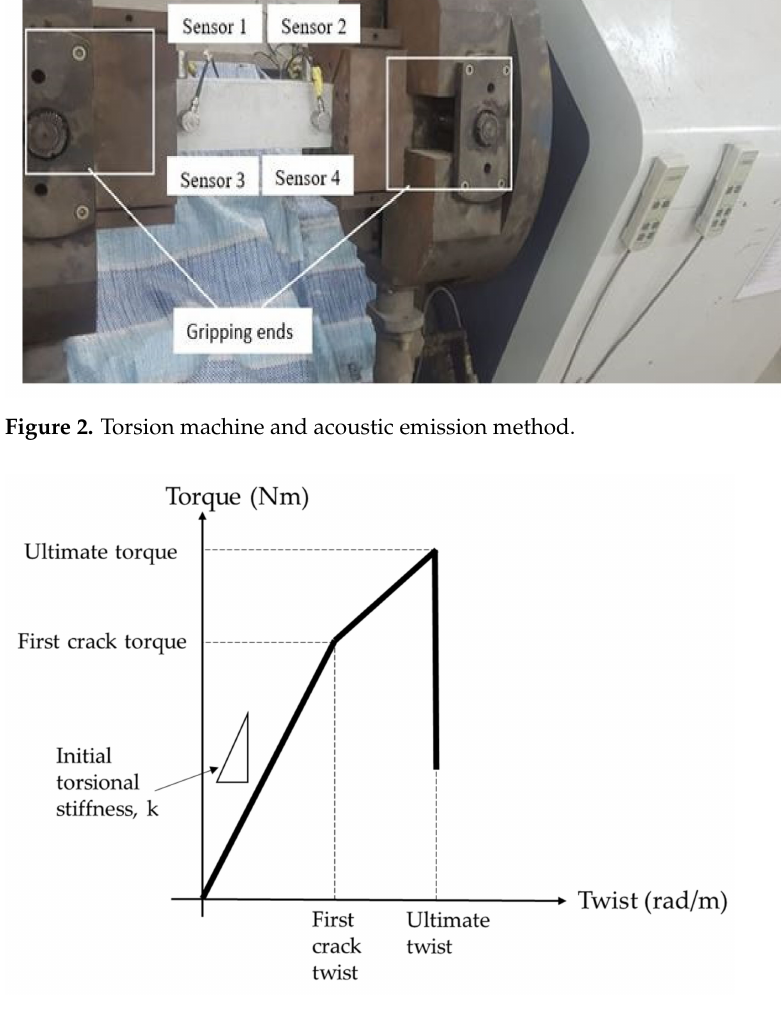
Figure 3. Modified torsional model up to ultimate